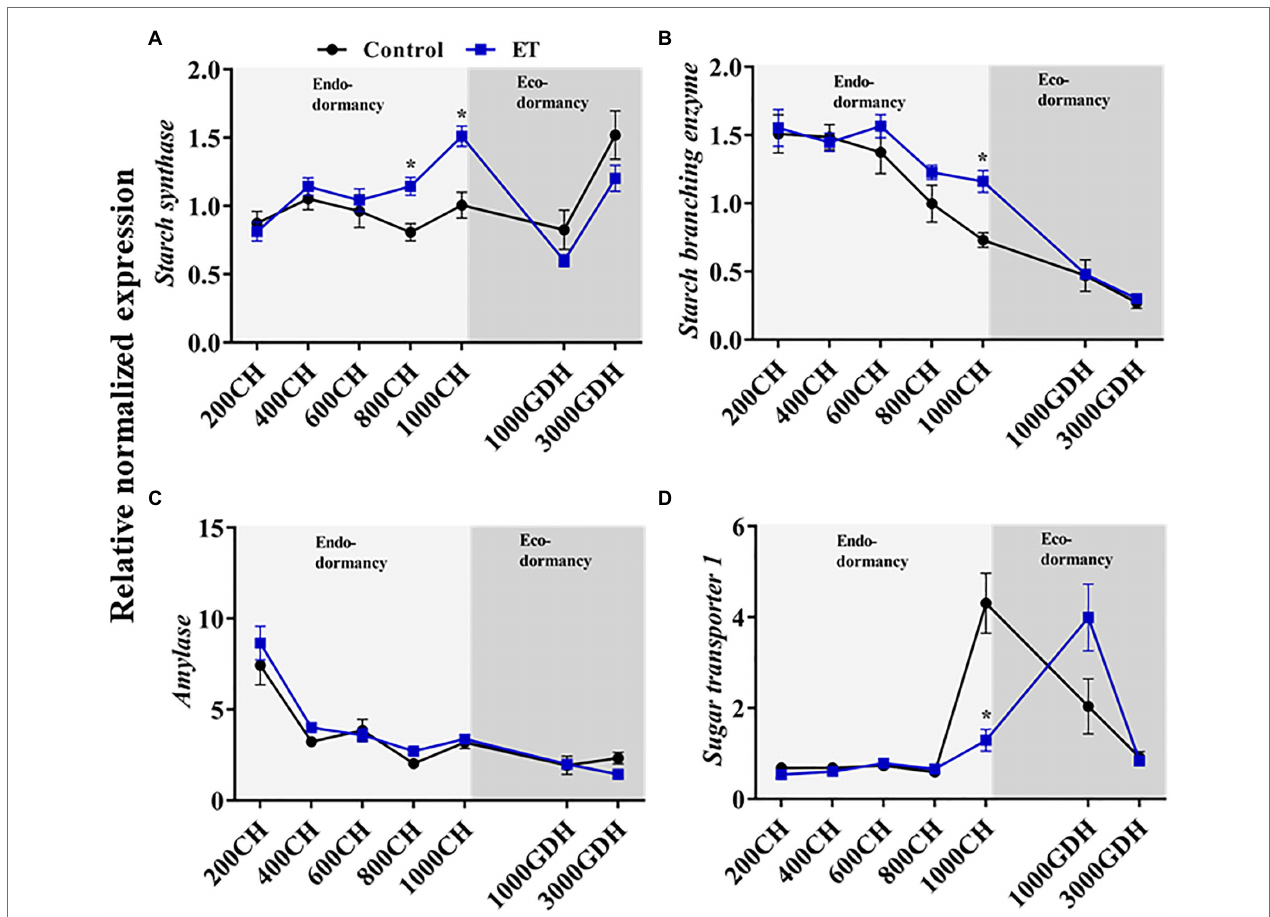
FIGURE 7 | Ethephon (ET)-mediated changes of the starch synthesis and degradations and the sugar transportation-related genes expression in peach “Red haven” floral buds during the dormancy. Starch synthase (A) , starch branching enzymes (B) , amylase (C) , and sugar transporter 1 (D) . Data represent the mean ± SEM for n = 3. Asterisks indicate significant differences between the control and ET-treated plant buds at different chilling hours (CH) and GDH; ∗ p <